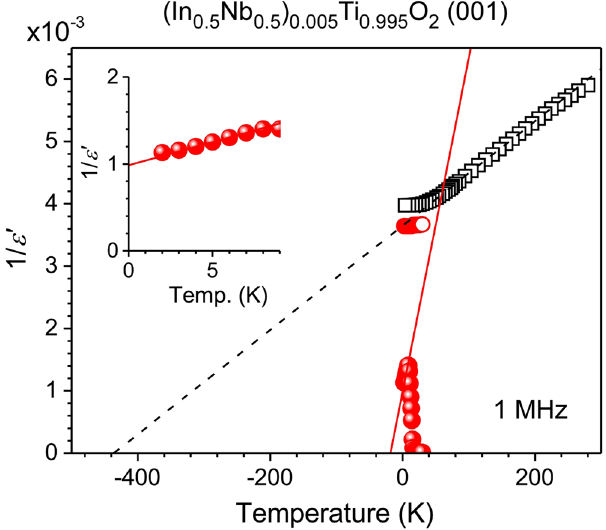
Figure 4. Inverse permittivity of a NITO-0.5% single crystal with a (001) wide surface measured at 1 MHz and plotted as a function of temperature by closed circles. Open circles and squares denote the results for pure TiO 2 obtained in the present study and those reported in ref. 30. The solid and broken lines indicate the extrapolated temperature dependences of NITO-0.5% and pure TiO 2 . These were obtained by fitting the linear parts of the plots using the Curie–Weiss law to estimate the virtual phase transition temperatures. The inset shows a magnified view of the temperature region below 9